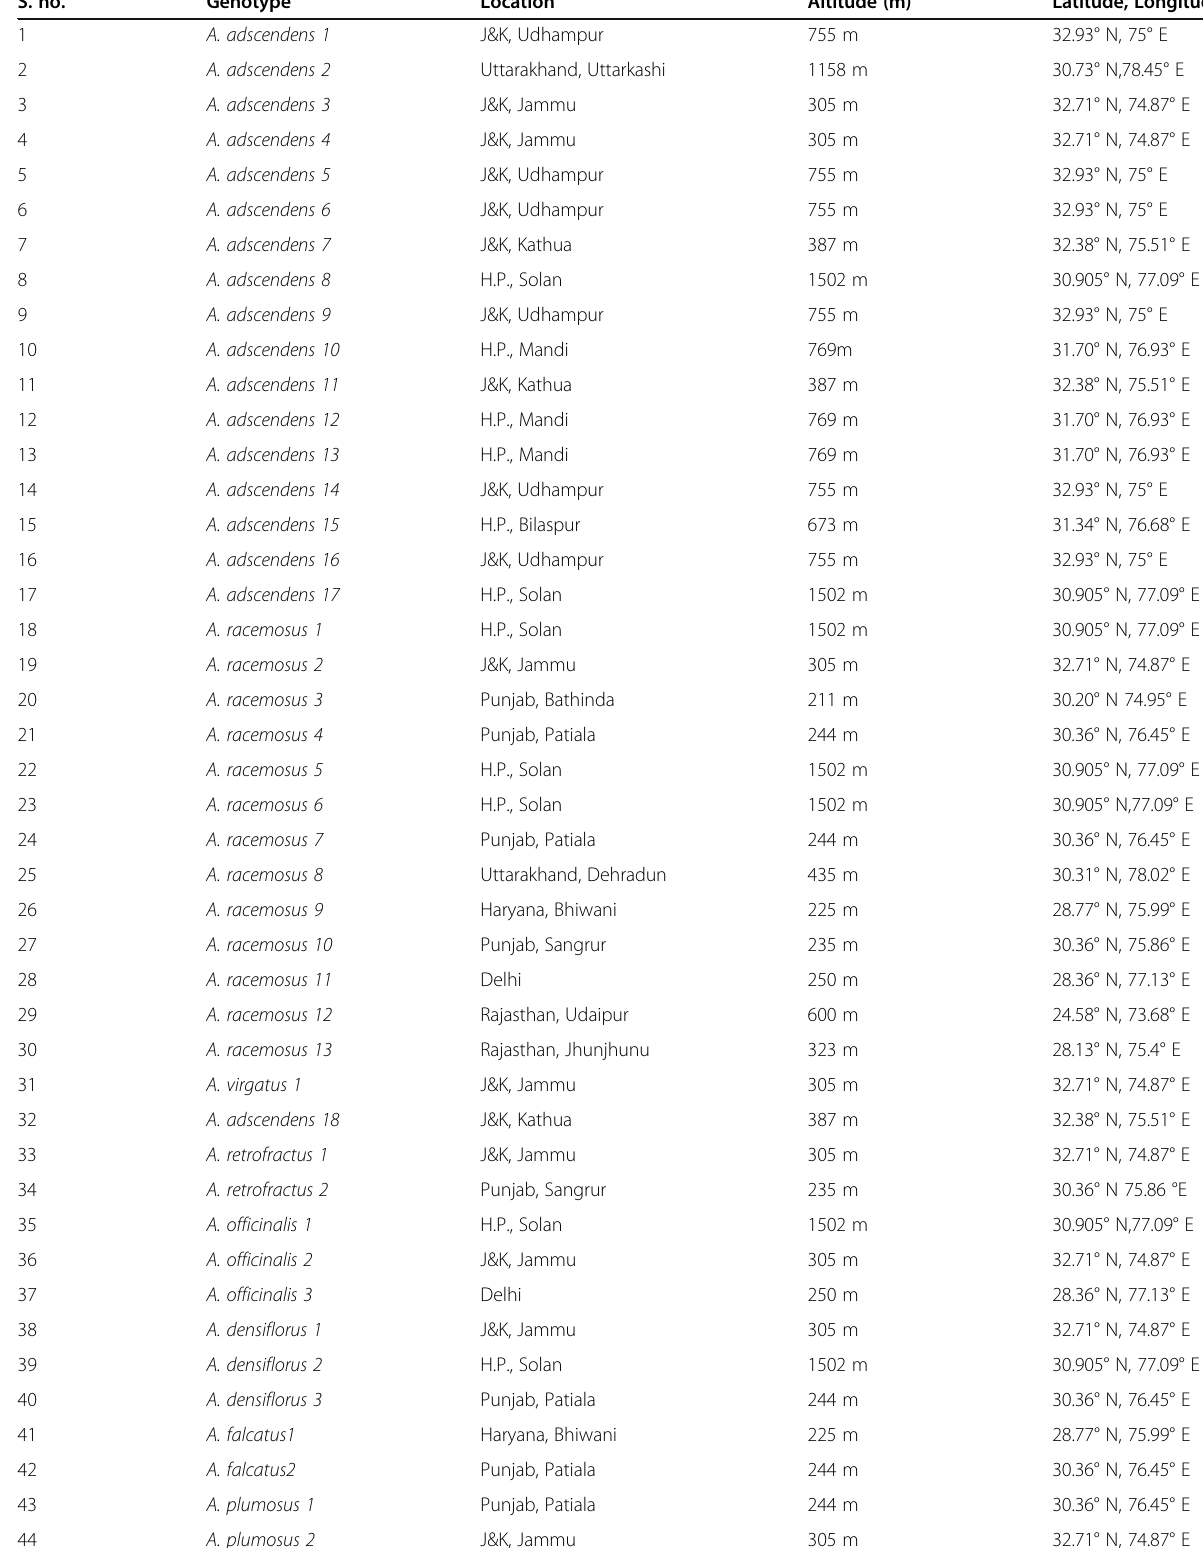
Table 1 List of genotypes with their